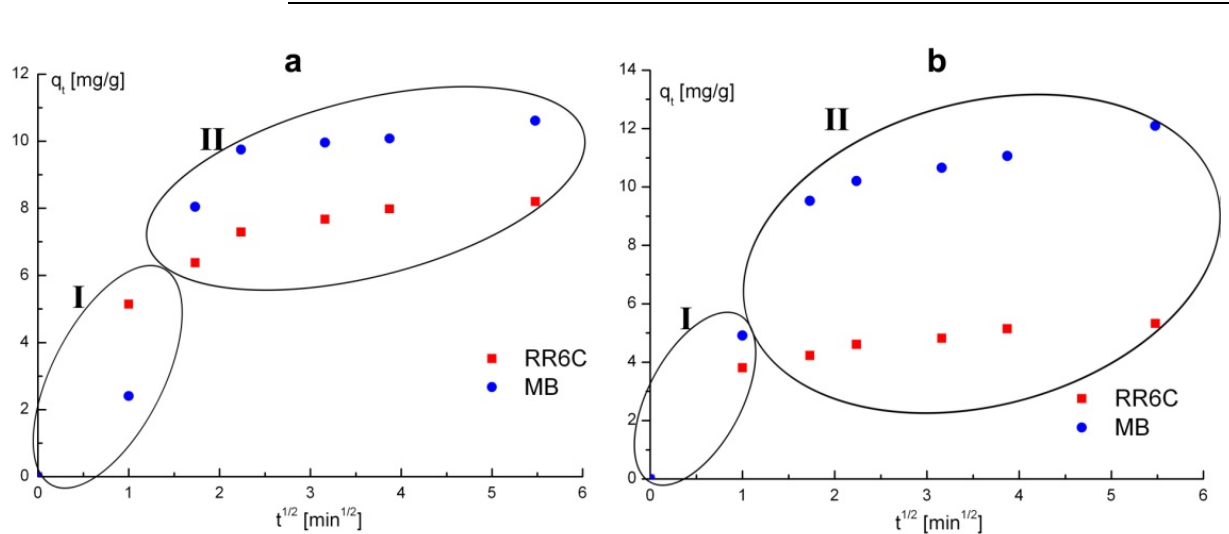
Figure 8. Plots of absorption capacity as function of t 1/2 for S3 ( a ) and S4 ( b ). Table 4. Kinetics parameters of Rhodamine B dye sorption onto the obtained samples (Q exp is the amount of adsorbed dyes obtained from experimental data).